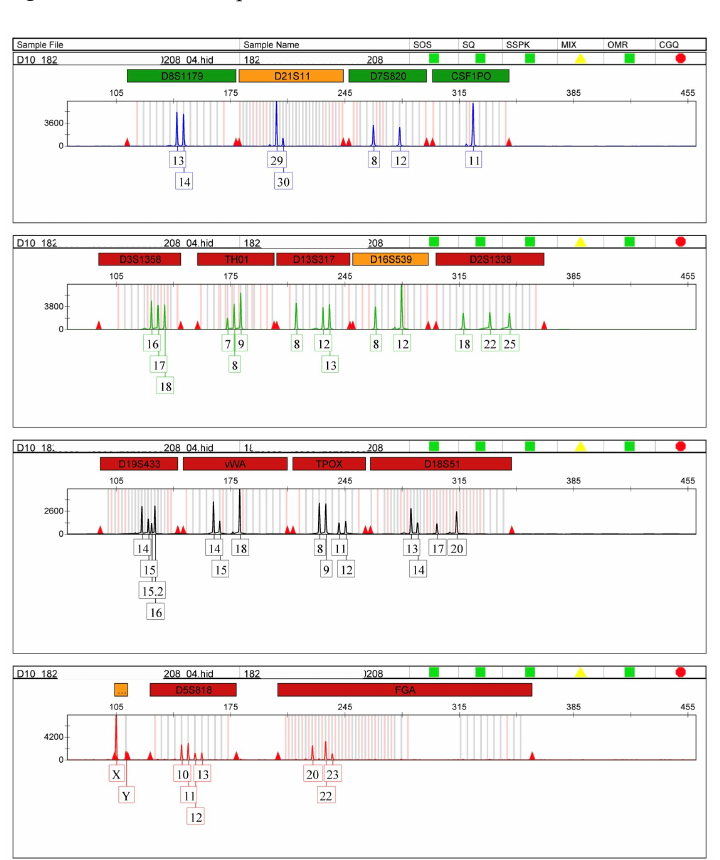
Figure 5. Two-person mixture DNA